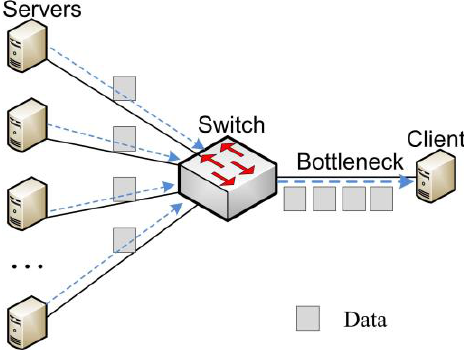
Figure 1. TCP incast scenario.